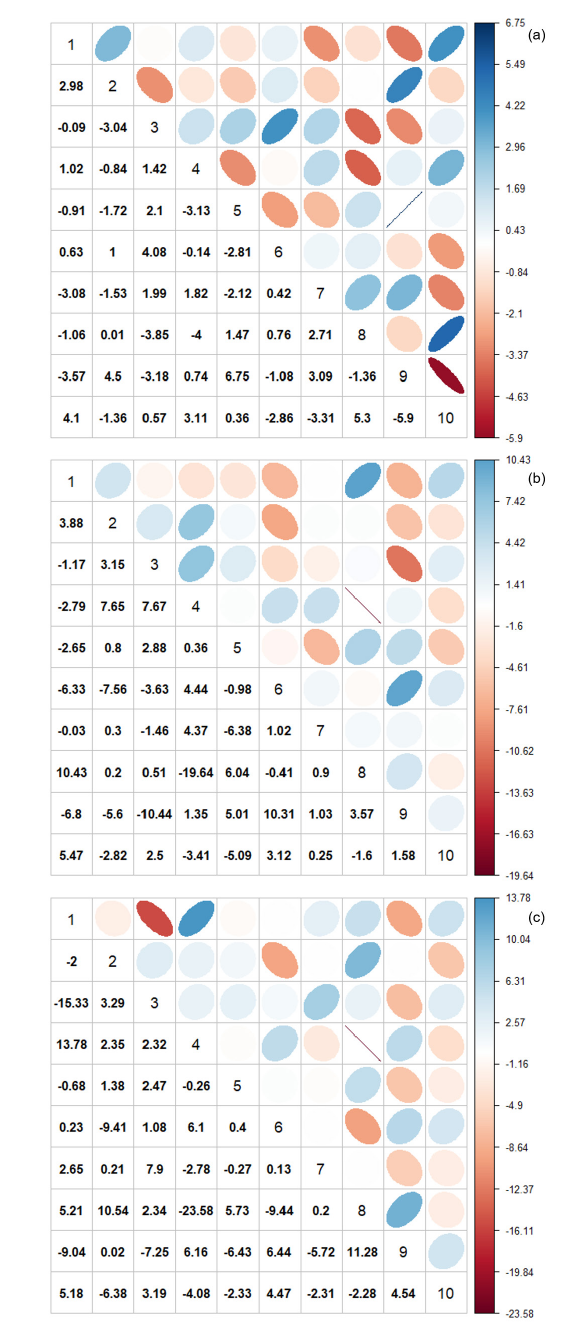
Figure 4. Specific combining ability for mega-trait 3 (grain yield) of 90 crosses conducted in Frederico Westphalen (a), Pato Branco (b) and Campos Novos